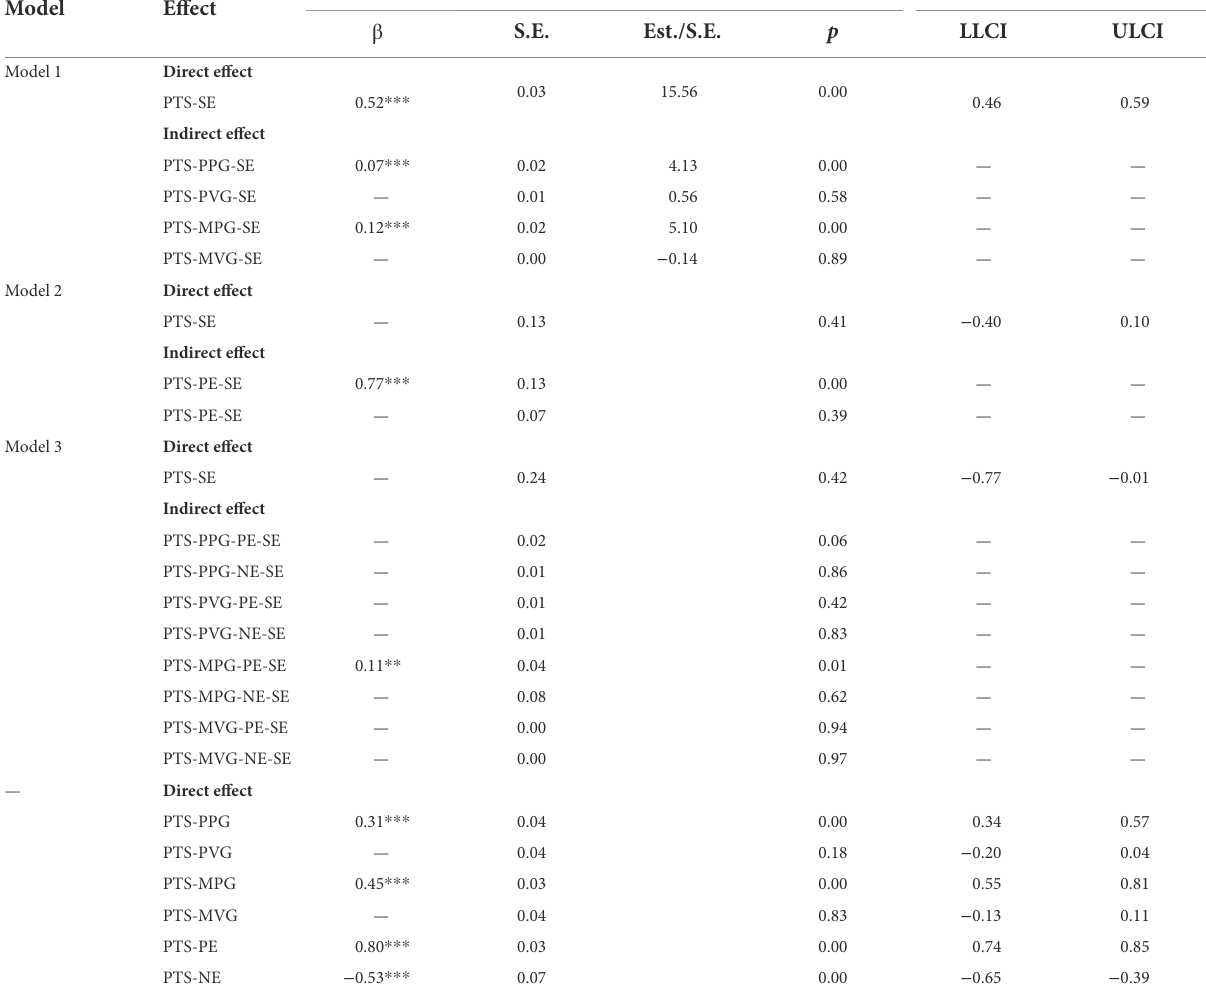
TABLE 2 Path coefficients and confidence intervals of all three models.